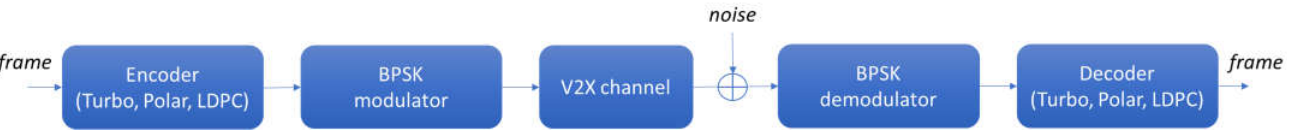
Figure 1. Simulation model using V2X stochastic channel model and BPSK modulation.